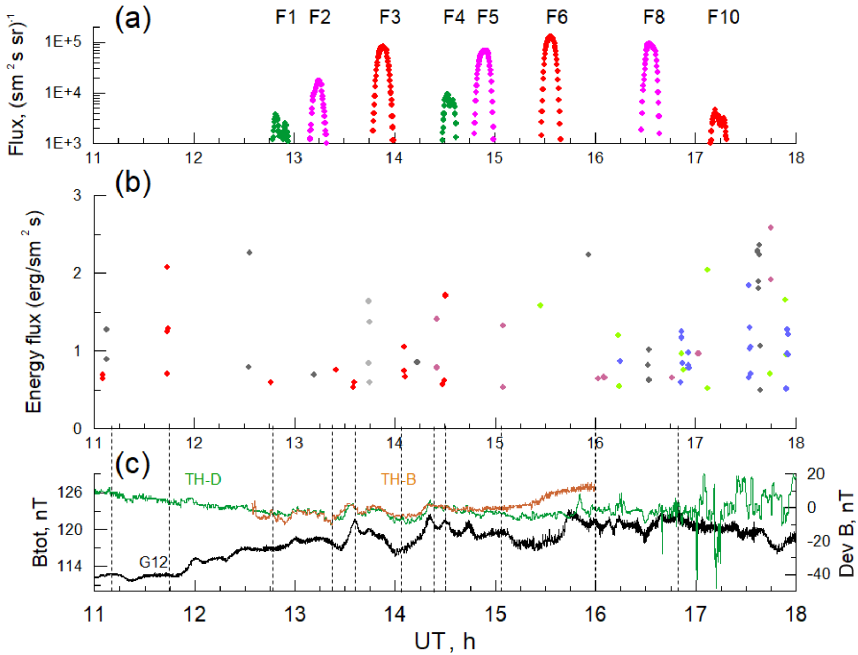
Figure 11. Dynamics of the geomagnetic field and particles on 1 August 2008: (a) FEE enhancements, (b) plasma precipitation at high latitudes, and dayside magnetic field perturbations observed by (c) GOES-12 (black), TH-D (green), and TH-B (brown). The left y axis corresponds to GOES-12 and the right y axis to TH-D and TH-B. The numbers indicate the FEE injections at ∼ 2 and ∼ 5LT (see Ta- ble 1); colours for the POES satellite are the same as in Fig. 2. Plasma precipitations are shown for the energy flux above the threshold of 0.5(ergcm 2 s) − 1 and are grouped in LT: 23–24LT (light grey), 0–2LT (grey), 5–6LT (blue), 12.5–15LT (red points), 15–16LT (violet),